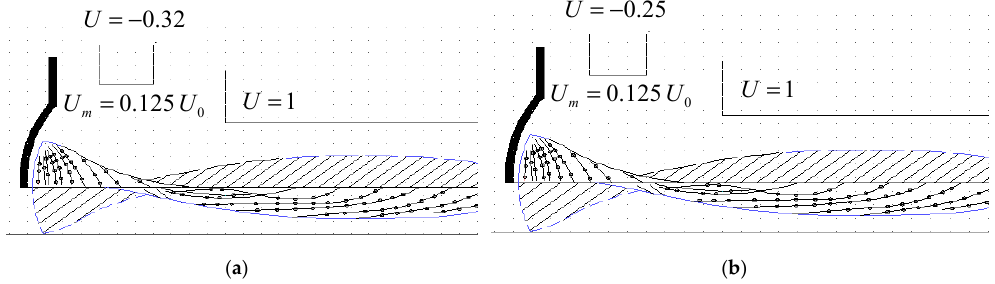
Figure 18. Trajectories of particles in the input part of the resotrode ( a ) with a concave cathode, ( b ) with a convex cathode .